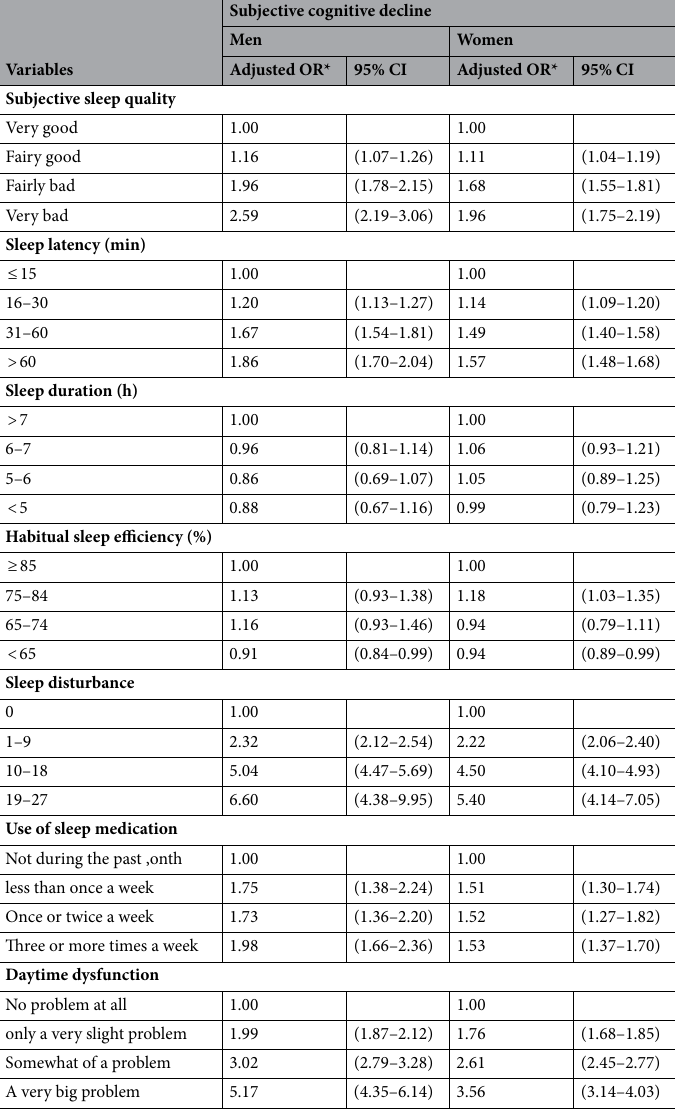
Table 3. The results of the analysis on the association between each component of the PSQI and subjective cognitive decline. PSQI Pittsburgh Sleep Quality Index, CI confidence interval, OR odds ratio. *OR adjusted for all covariates considered in the